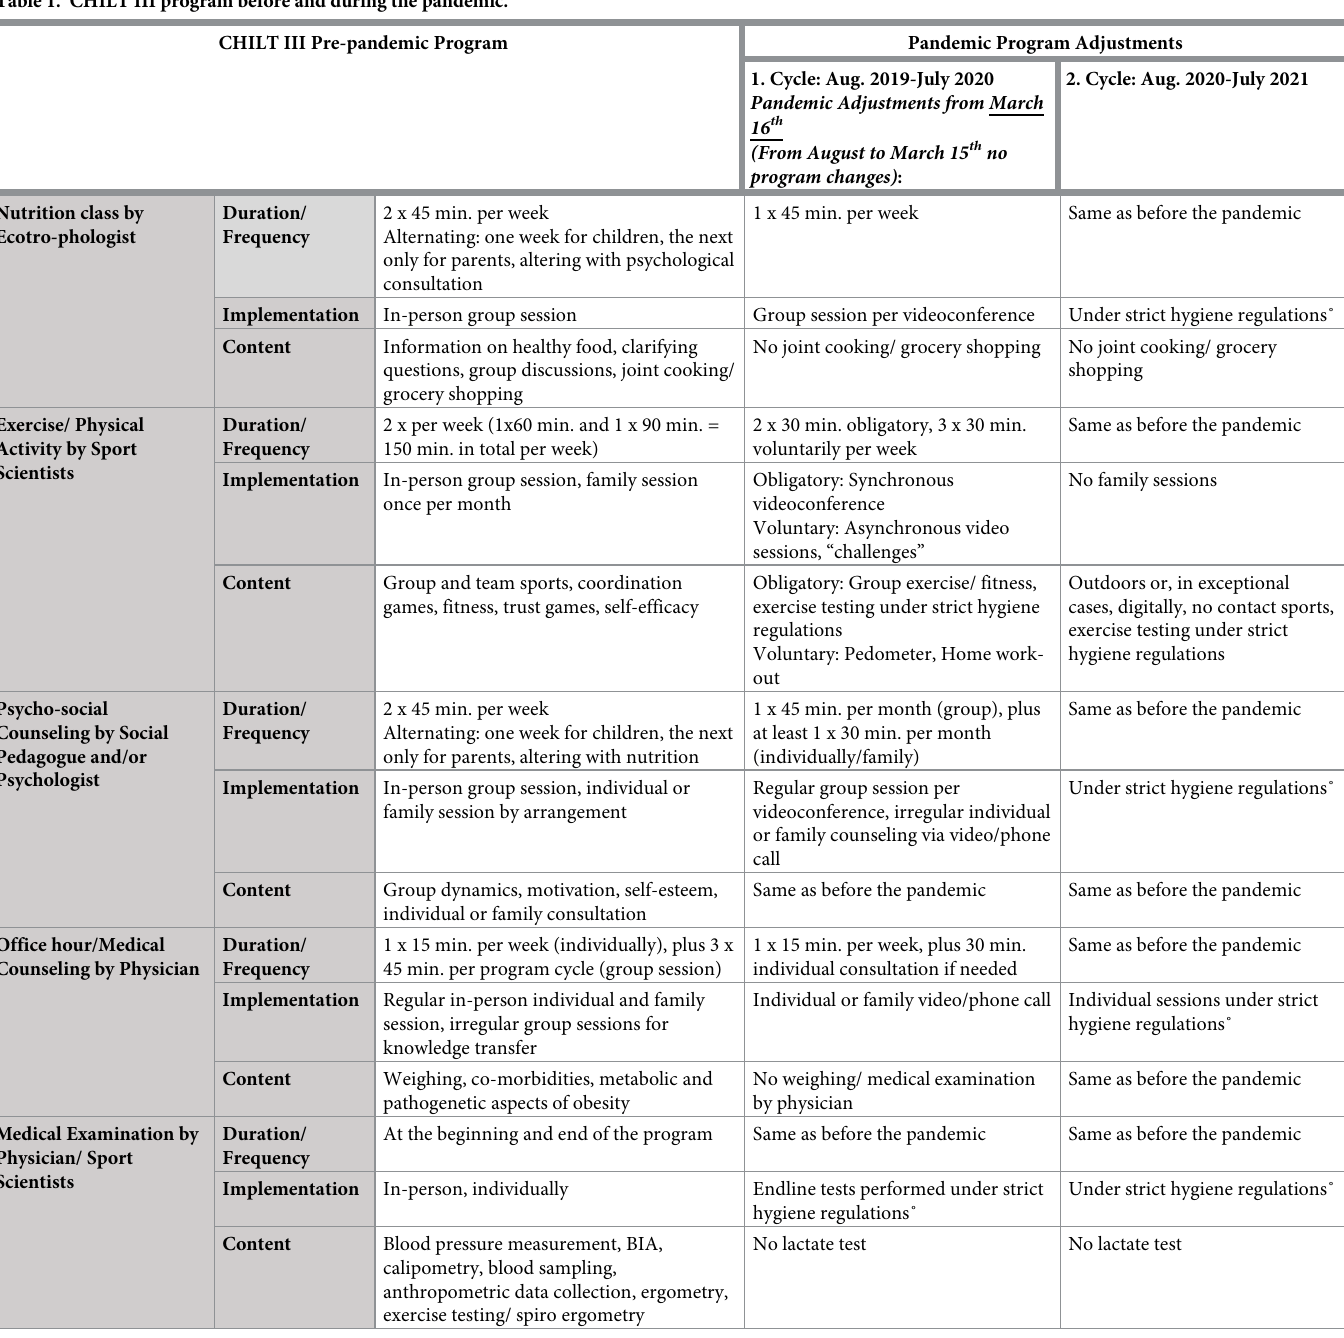
Table 1. CHILT III program before and during the